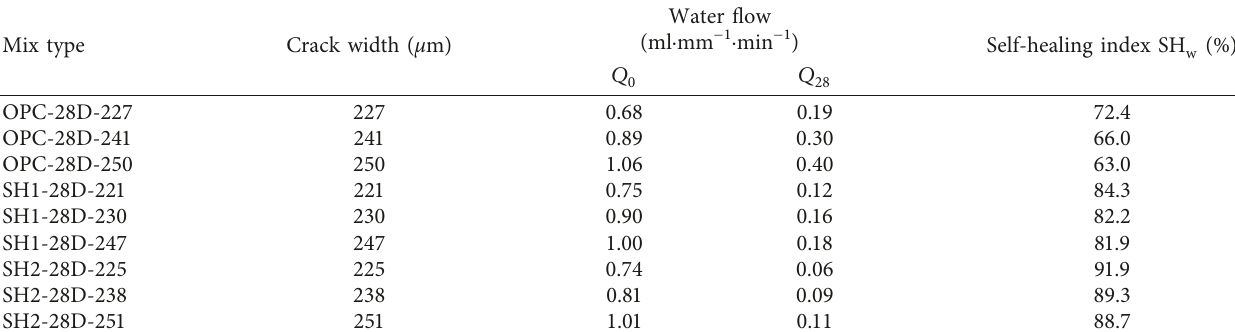
Table 5: Water flow rate and self-healing indices of the three